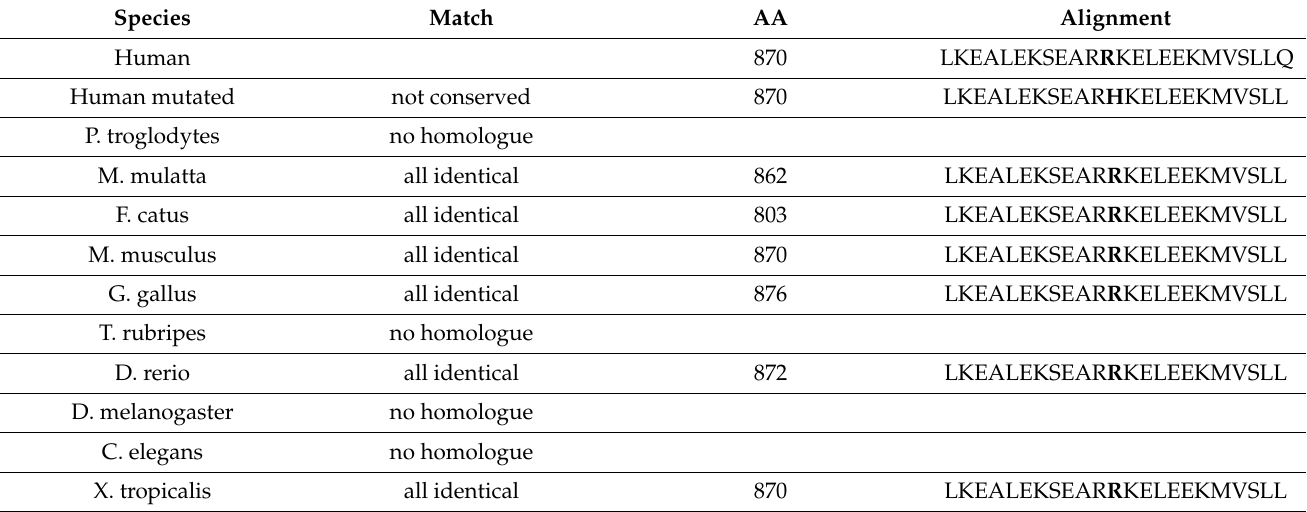
Table 4. Multiple protein sequence alignment of amino acid 870 in MYH7